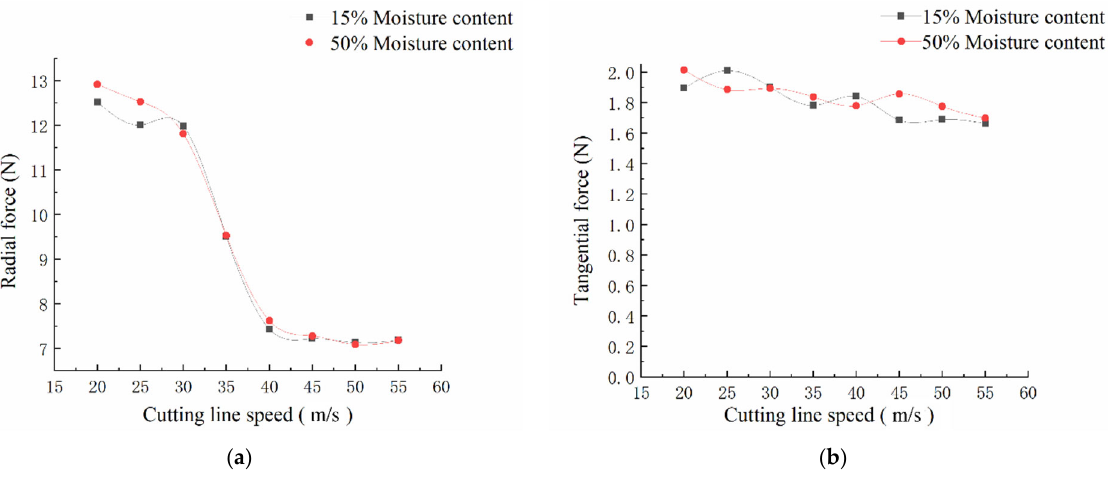
Figure 6. ( a ) Effect of moisture content on radical force; ( b ) effect of moisture content on tangential